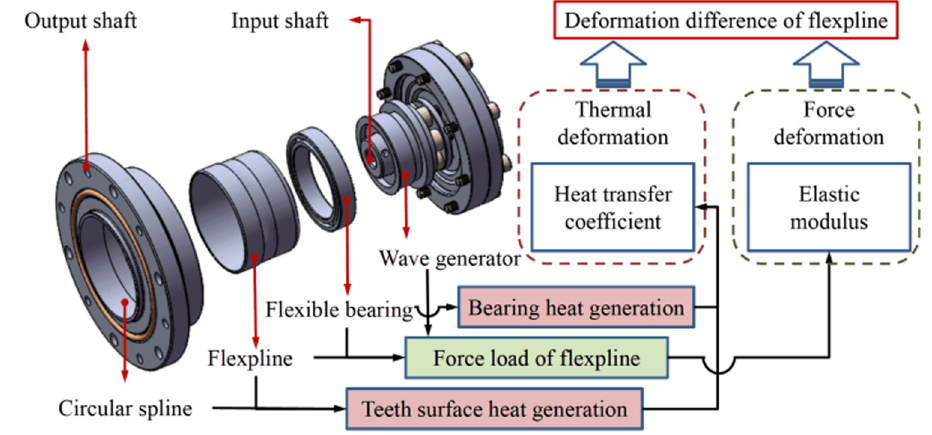
Figure 1: FS deformation principle of HD.